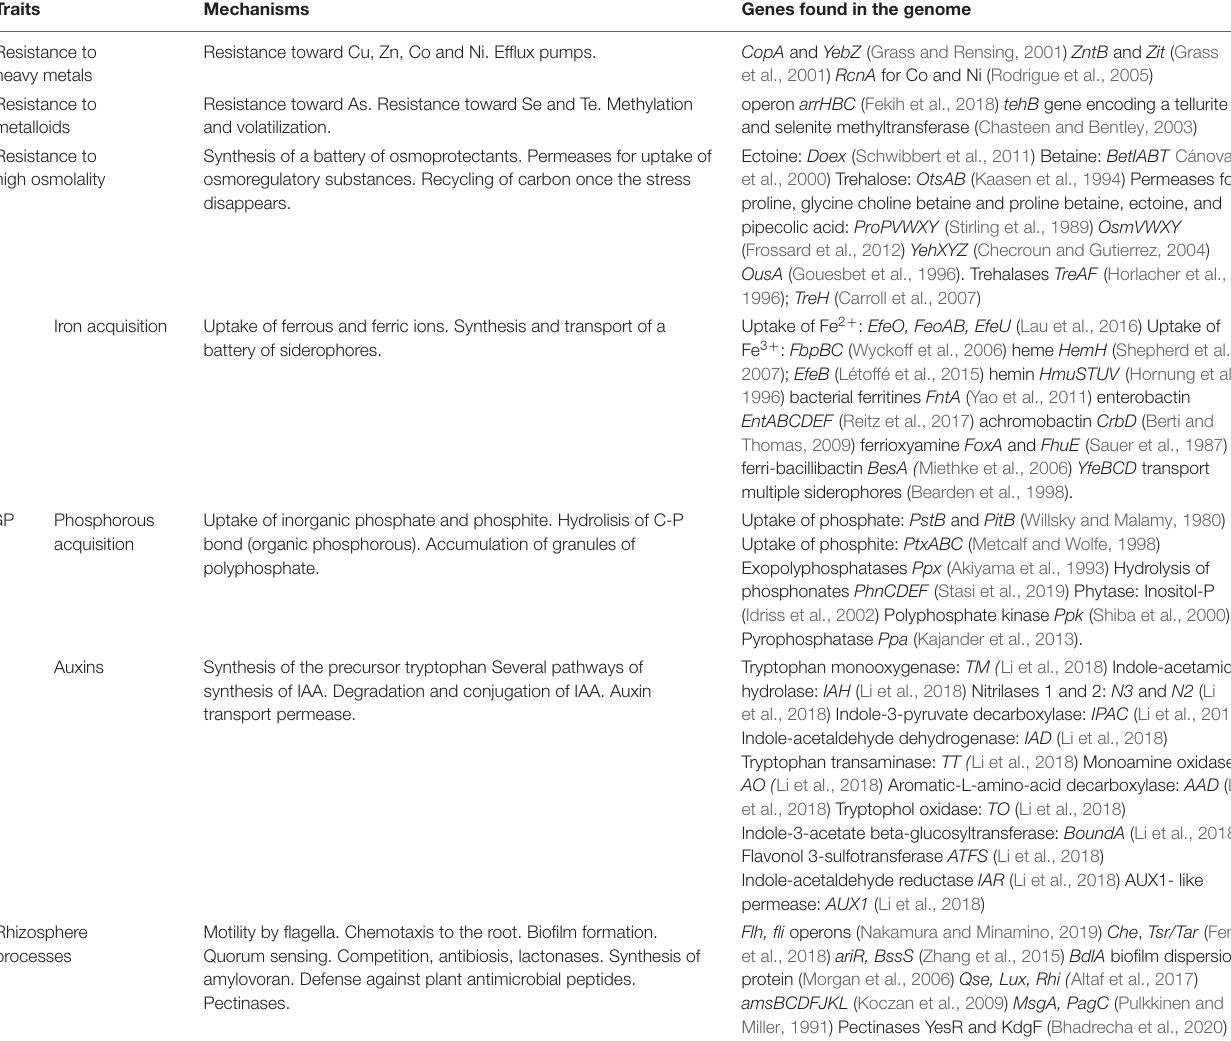
TABLE 4 | Summary of mechanisms (and the corresponding traits) that justify the plant growth promoting properties and resilience of Pantoea agglomerans